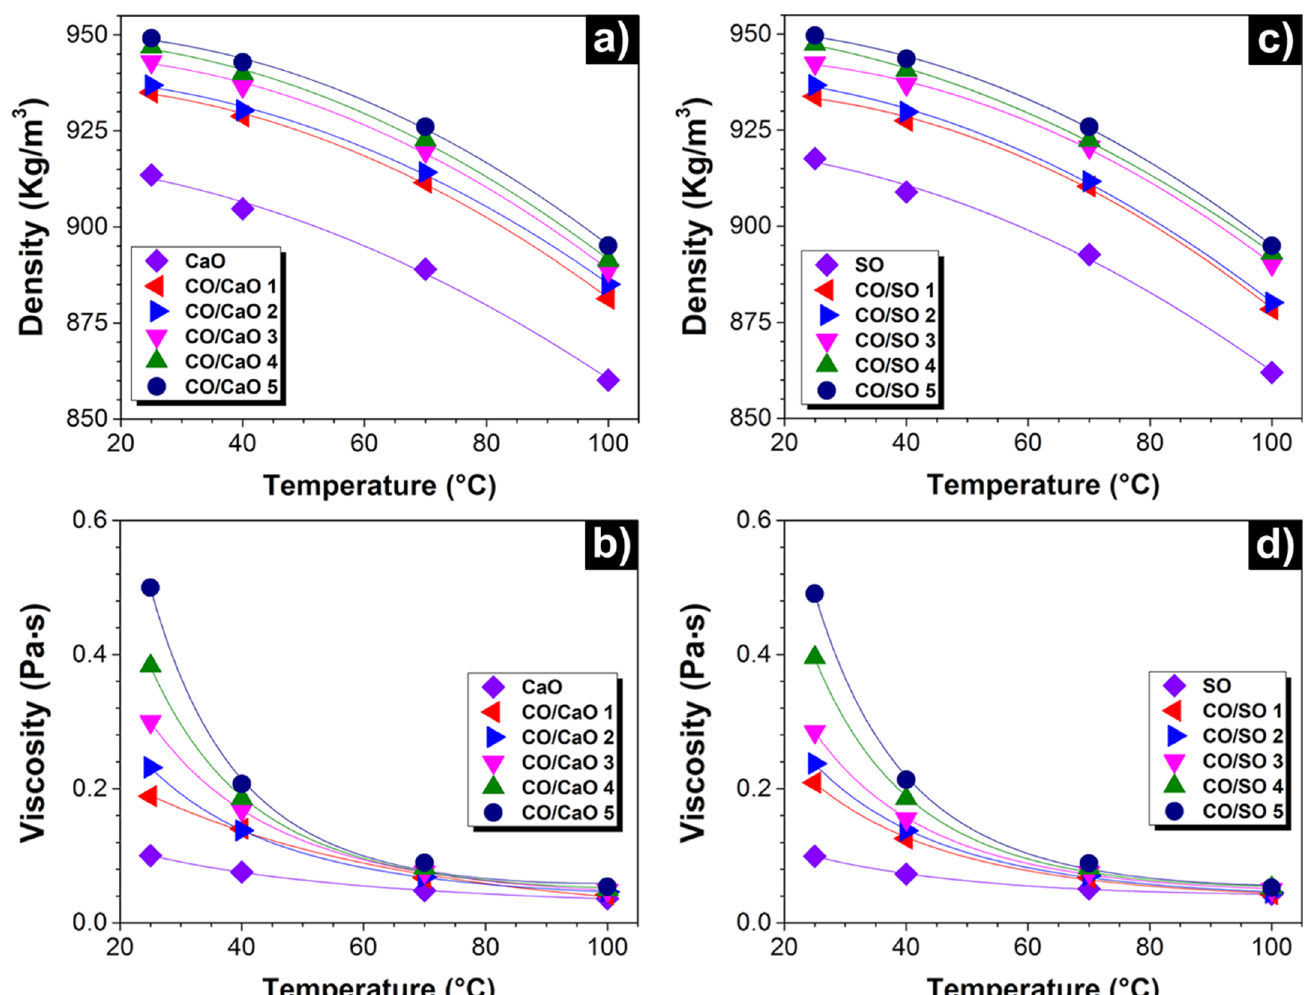
Figure 3. Density and dynamic viscosity of binary oil mixtures as a function of temperature: CO/CaO ( a , b ) and CO/SO ( c , d ).